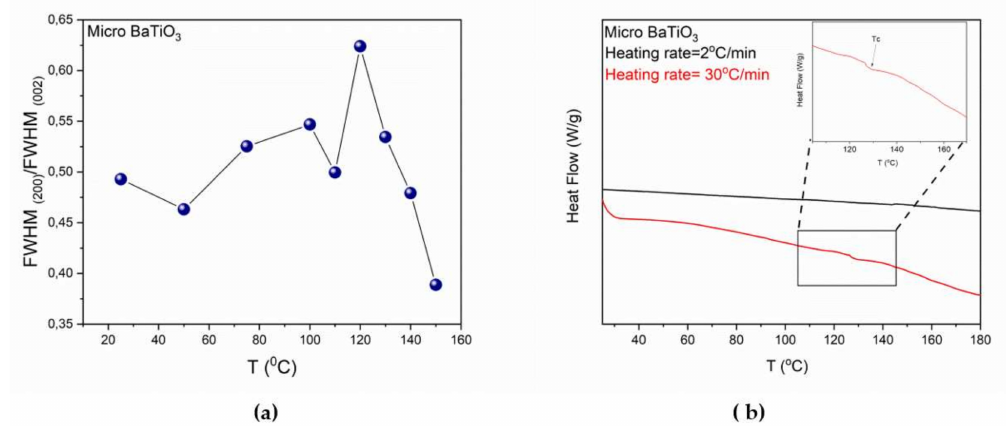
Figure 3. ( a ) FWHM (200) / FWHM (002) as a function of temperature for micro-BT particles and ( b ) DSC thermograph of micro-BT particles varying the heating rate, endo down. Lines in Figure 2a are visual